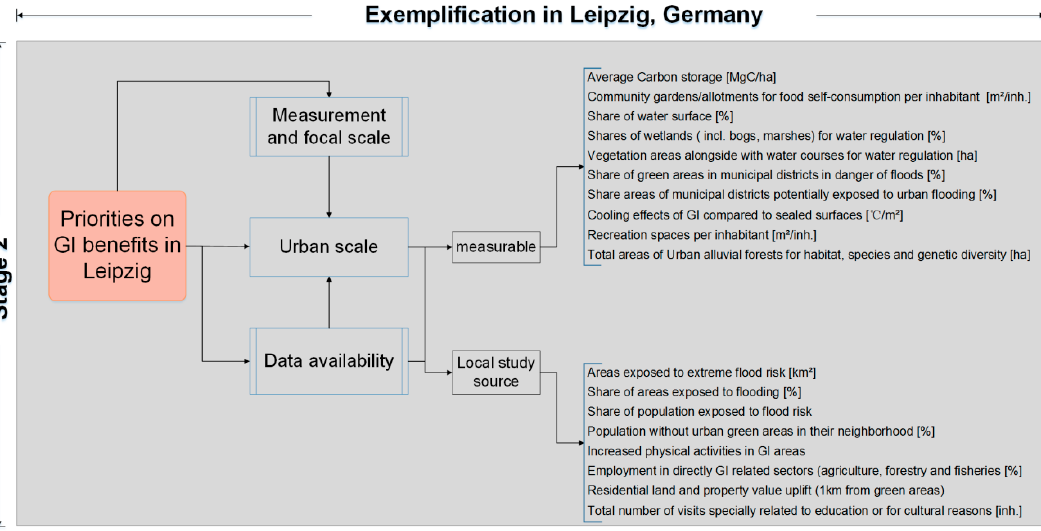
Figure 6. Results from indicator selections for the illustrative case in Leipzig, Germany.